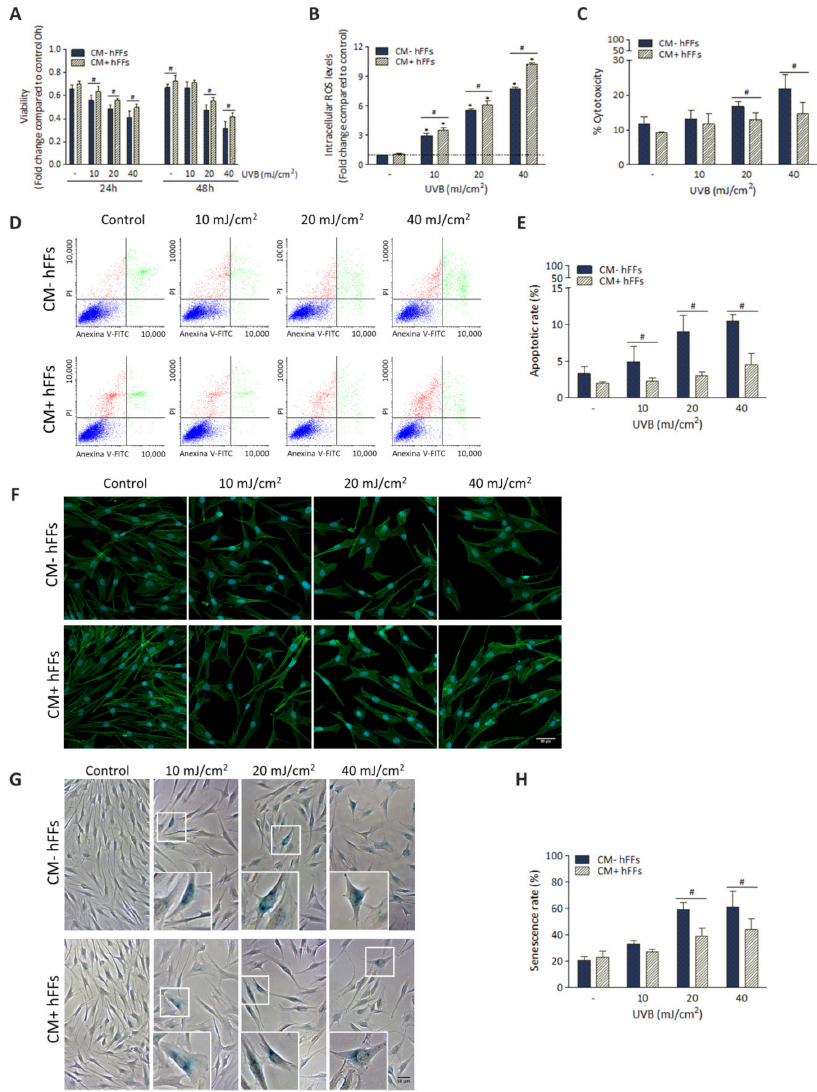
Figure 5. The photoprotective effect of HC016-CM on hFFs exposed to UVB radiation. ( A ) The viability of CM − and CM+ hFFs was measured at 24 and 48 h after UVB exposure and results were standardized relative to values of non-irradiated non-treated cells at time 0 h. ( B ) ROS levels were measured at 1 h and results were normalized to non-irradiated CM − hFFs. ( C ) Percentage of cyto- toxicity as measured by LDH levels in the culture medium 48 h post-irradiation. ( D ) Representative graphs of annexin V/PI assay performed by flow cytometry at 24 h. Annexin V − /PI − stains live cells (blue), annexin V+/PI − or V+/PI − early or late apoptosis respectively (green) and annexin V − /PI+ necrosis (red). ( E ) Quantification of cells undergoing early and late apoptosis. ( F ) Representative fluorescence images of F-actin cytoskeleton obtained at 48 h post-irradiation (scale bar: 50 µ m). Images show F-actin filaments stained with green fluorescent Alexa iFluor 488-conjugated phalloidin, and nuclei stained with Hoechst (blue). ( G ) SA- β -gal staining in CM − and CM+ hFFs 48 h after UVB irradiation. Representative phase-contrast images (scale bar: 50 µ m). Senescent cells are identified by the blue staining of the cytoplasm due to SA- β -gal activity. ( H ) Percentage of SA- β -gal positive cells out of the total number of cells counted. Data are expressed as mean ± SD. * p < 0.05 compared with non-irradiated CM − hFFs; # p < 0.05 between HC016-CM-treated hFFs and untreated